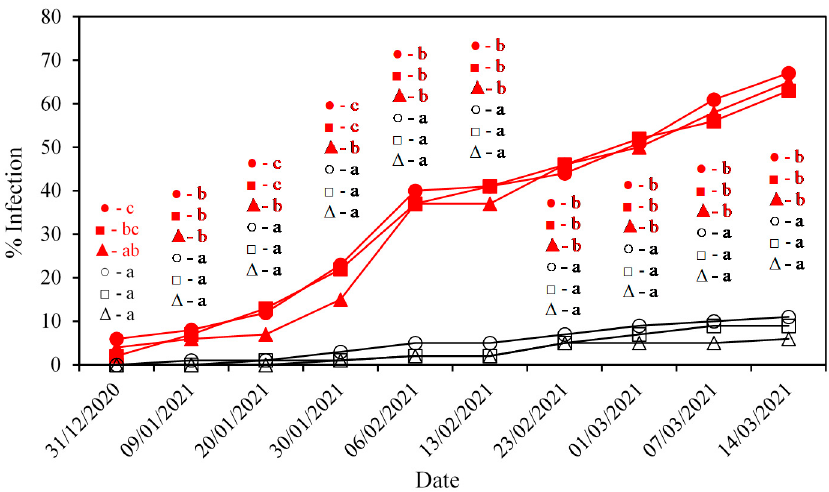
Figure 6. Development of Fusarium crown and root rot percentage of infection over time in the sectors with different irrigation and substrates. Treatments: T1-H ( ■ ), T1-S ( □ ), T2-H ( ▲ ), T2-S ( Δ ), T3-H ( ● ) and T3-S ( ○ ). S, typical soil substrate “ enarenado ”; H, coconut fiber substrate. Different letters in the same column indicate statistically significant differences with a confidence level of 95.0% ( p -value ≤ 0.05).